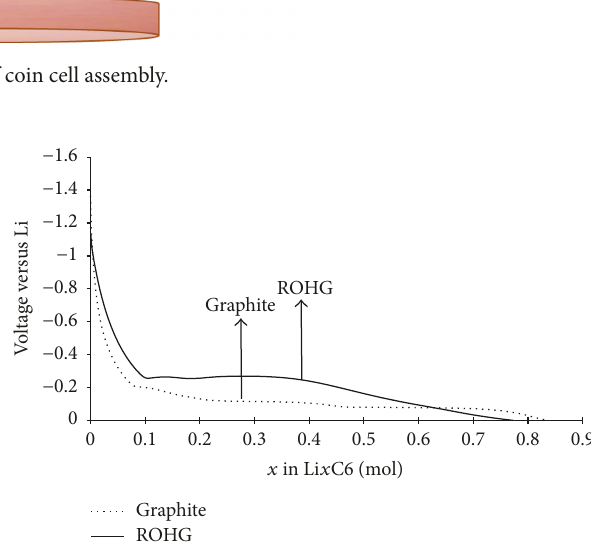
Figure 2: Plot of moles of Li as a function of voltage with reference to Li